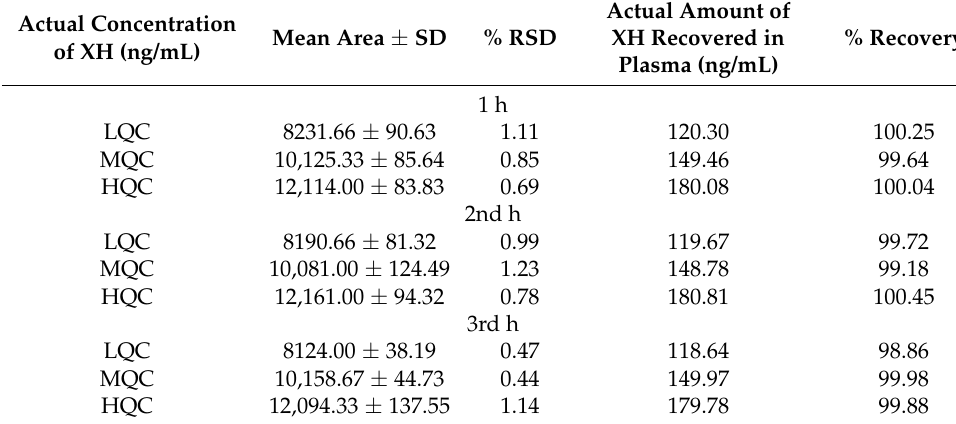
Table 6. Short term stability for plasma samples of